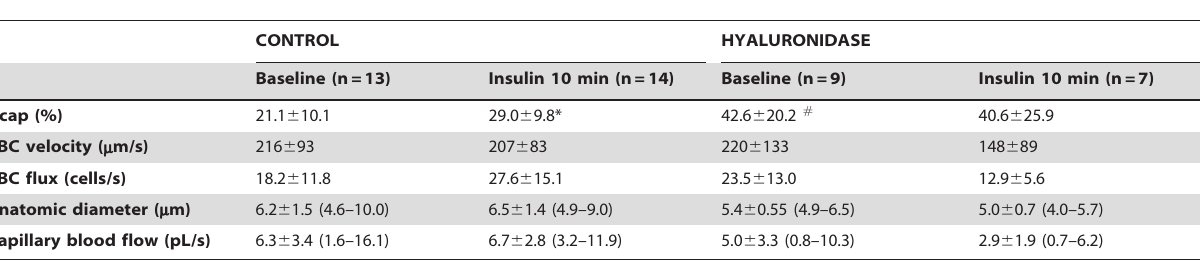
Table 3. Capillary hemodynamics measured in the cremaster